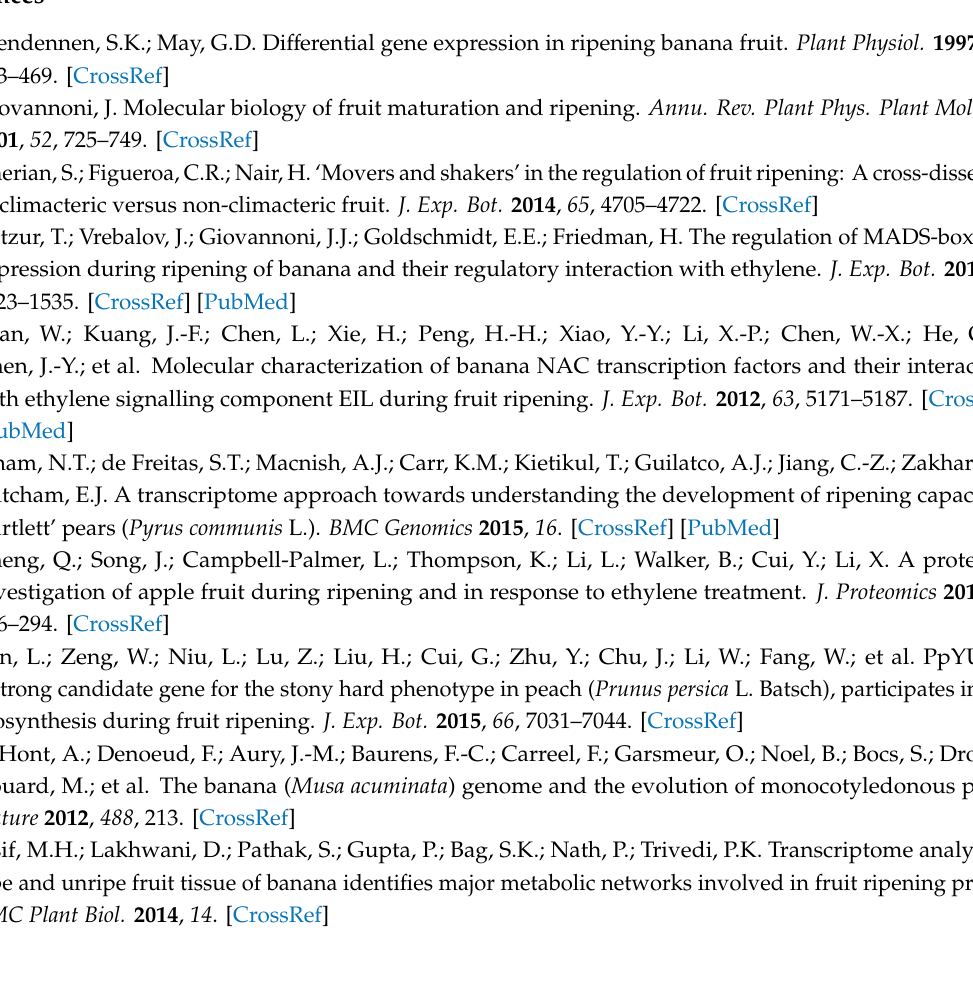
Figure S1: Representative two-dimensional electrophoresis profiles of proteins from peel tissues during banana ripening, Figure S2: A comprehensive protein–protein interaction network in the peel of banana fruit during ripening, Figure S3: Correlation matrix between di ff erentially expressed genes / protein and metabolites, Figure S4: Graphical output of up-regulated signal transduction-related genes in the peel of banana fruit during ripening, Figure S5: Graphical output of down-regulated TFs in the peel of banana fruit during ripening, Figure S6: Di ff erentially expressed TFs genes during banana fruit ripening, Figure S7: Schematic diagram of the metabolism pathway using MapMan visualization platform, Table S1: Primers for real-time qRT-PCR, Table S2: Di ff erentially accumulated volatile compounds in the peel of banana fruit during ripening, Excel S1: Di ff erentially expressed genes in the peel of banana fruit during ripening, Excel S2: Di ff erentially expressed proteins in the peel of banana fruit during